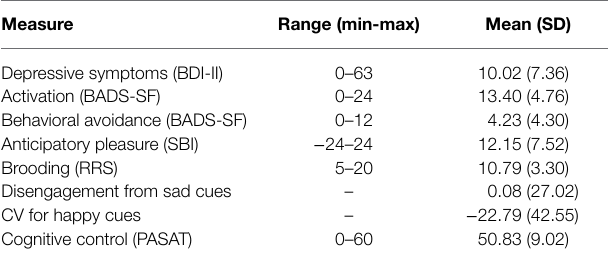
TABLE 2 | Means and standard deviations for all variables.